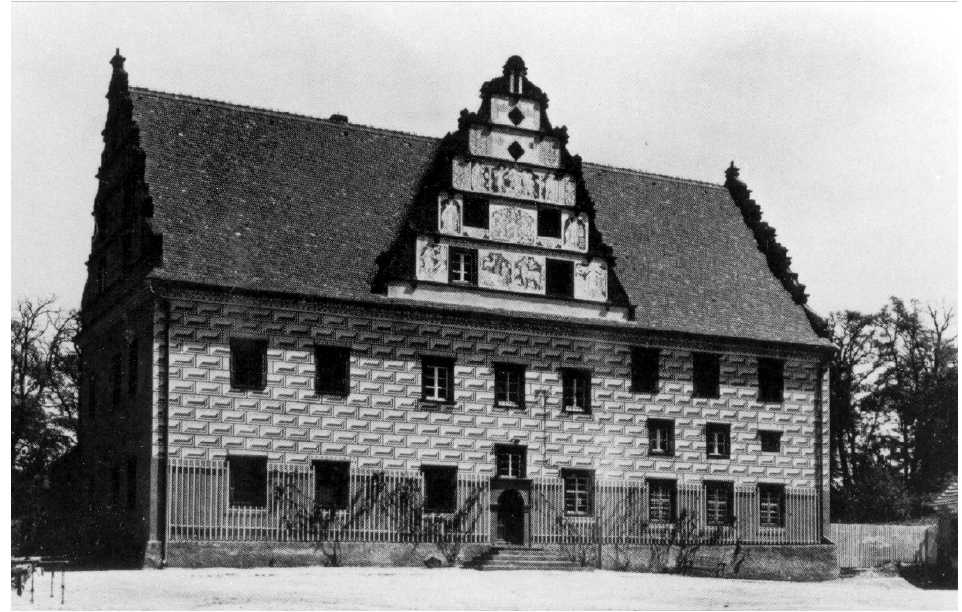
Figure 29. Sgraffito decoration of the manor house in Pawłowice after thorough conservation carried out in 1938. Source: Grundmann (1982, vol. 2, p. 199).